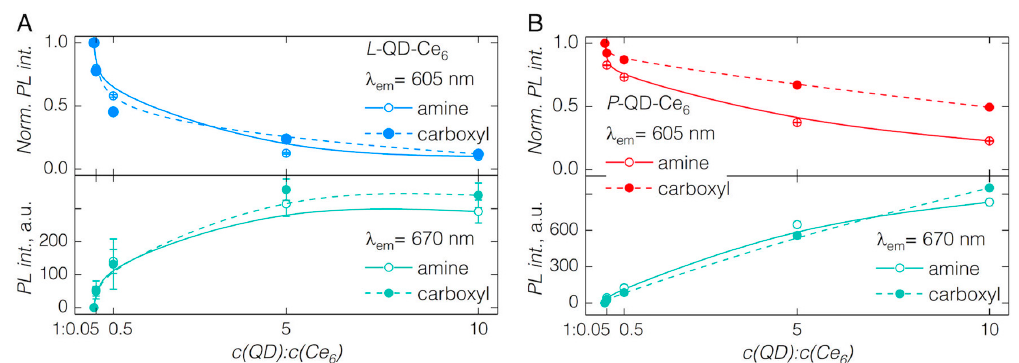
Figure 3. Normalized emission intensity of pure QDs and in the presence of increasing amount of Ce 6 together with absolute fluorescence intensity of Ce 6 after the binding to QDs. ( A ) L -QD-Ce 6 ; ( B ) P - B ) P -QD-Ce 6 . Line plots are introduced to guide the QD-Ce 6 . Line plots are introduced to guide the eye. (